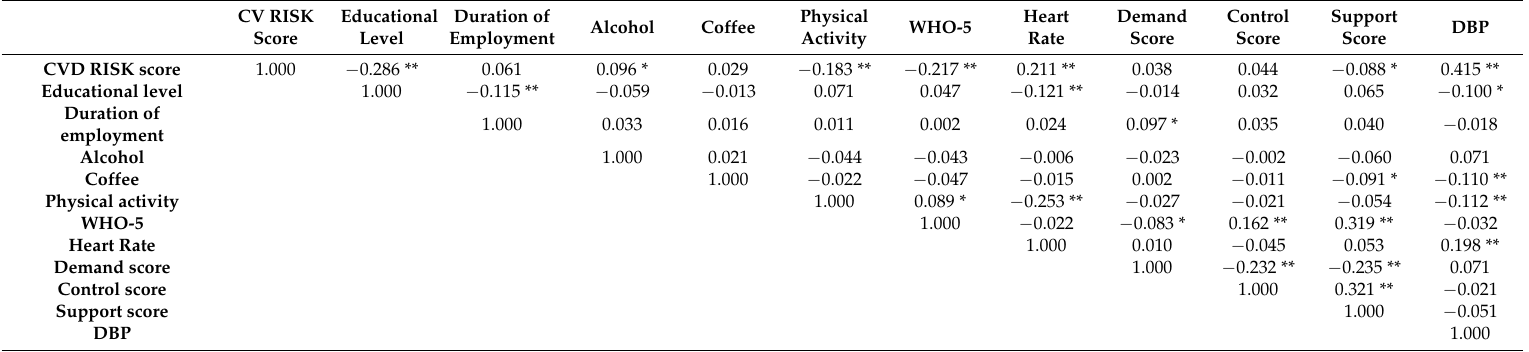
Table 5. Spearman correlation matrix (* p < 0.05; ** p <